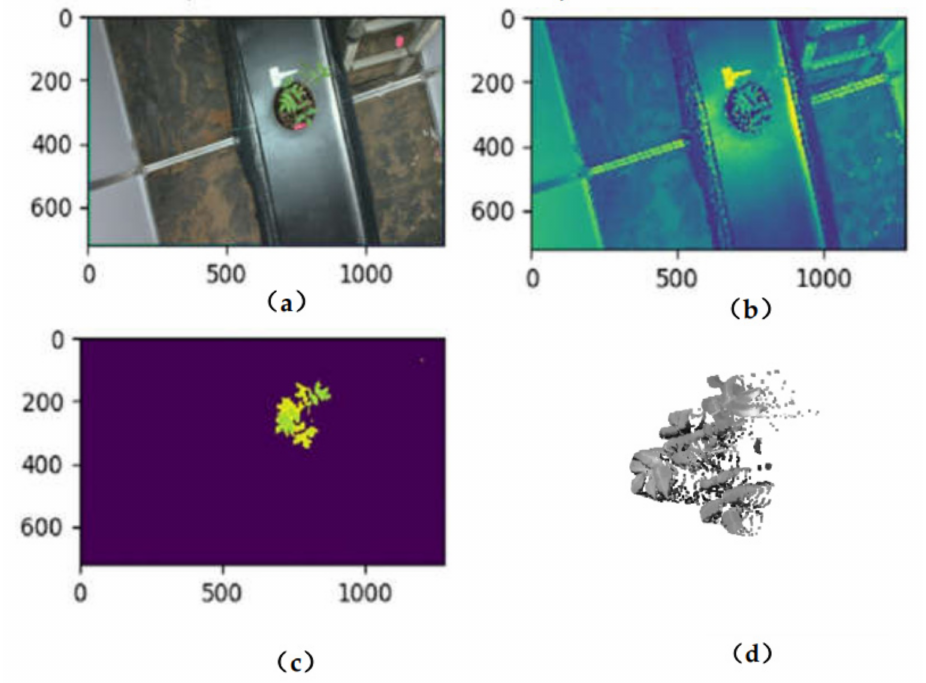
Figure 3. Original RGB image for a single T. sinensis seedling ( a ), grayscale image for T. sinensis seedling ( b ), depth image with depth information ( c ) and 3D point cloud image ( d